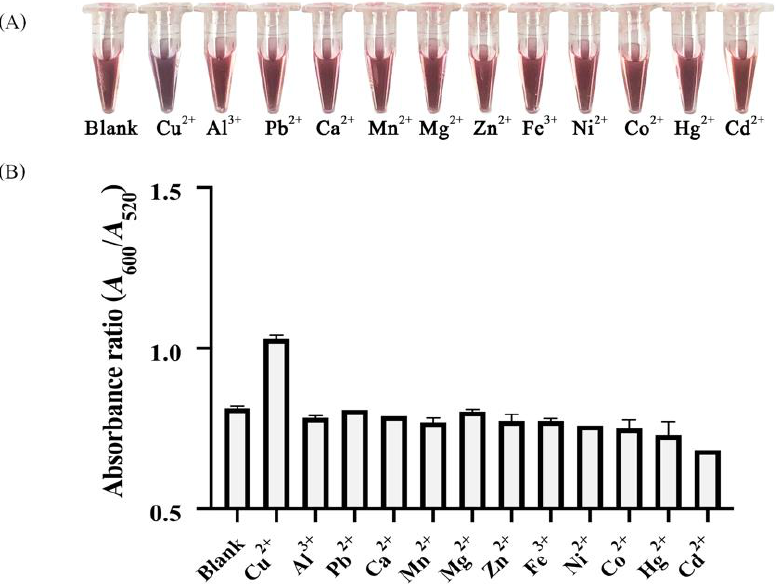
Figure 7. ( A ) Color changes and ( B ) absorption peak ratios at 600 nm and 520 nm, i.e., A 600 / A 520 , of the hybrid sensing solutions in the presence of 1 ppm of the tested metal